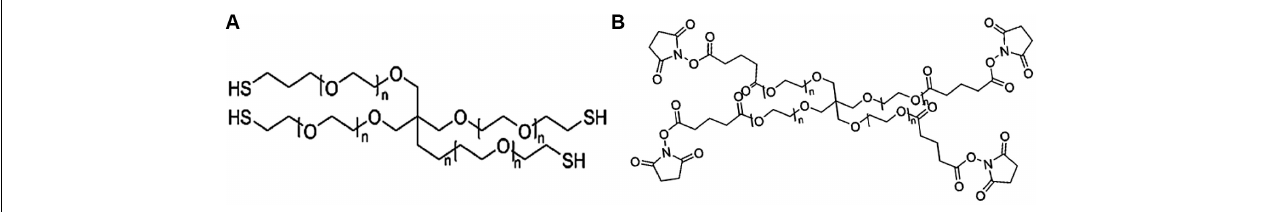
FIGURE 5 | The chemical structures of (A) pentaerythritol poly(ethylene glycol) ether tetrathiol and (B) pentaerythritol poly(ethylene glycol) ether tetrasuccinimidyl glutarate.